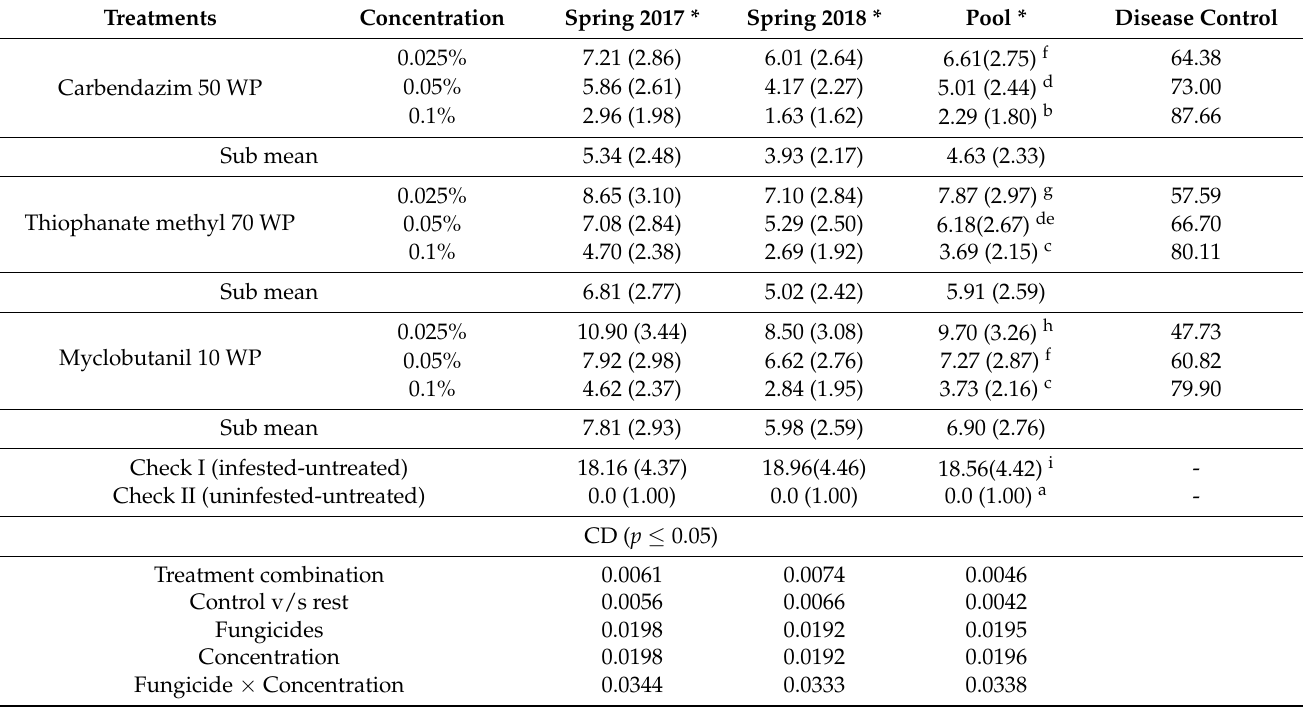
Figure 9. Comparative bar chart designates the effect of systemic fungitoxicants under in vitro con- ditions on host A. bisporus mycelium, where Carben = Carbendazim 50 WP, Myclo = Myclobutanil 10 WP, Thiopha = Thiophanate methyl 70 WP, Hexacona = Hexaconazole 5 EC, Difenoc = Difeno- conazole 25 EC, Sys INHH = mycelial inhibition of host. Table 9. Impact of systemic fungitoxicants in casing on percent intensity of green mold